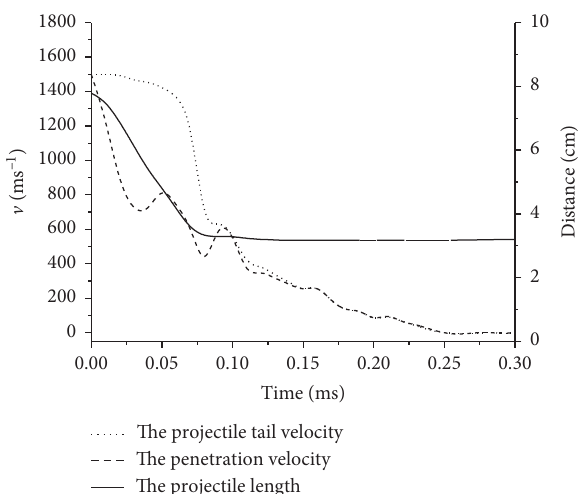
Figure 4: Time course changes of the projectile tail velocity, penetration velocity, and projectile length.